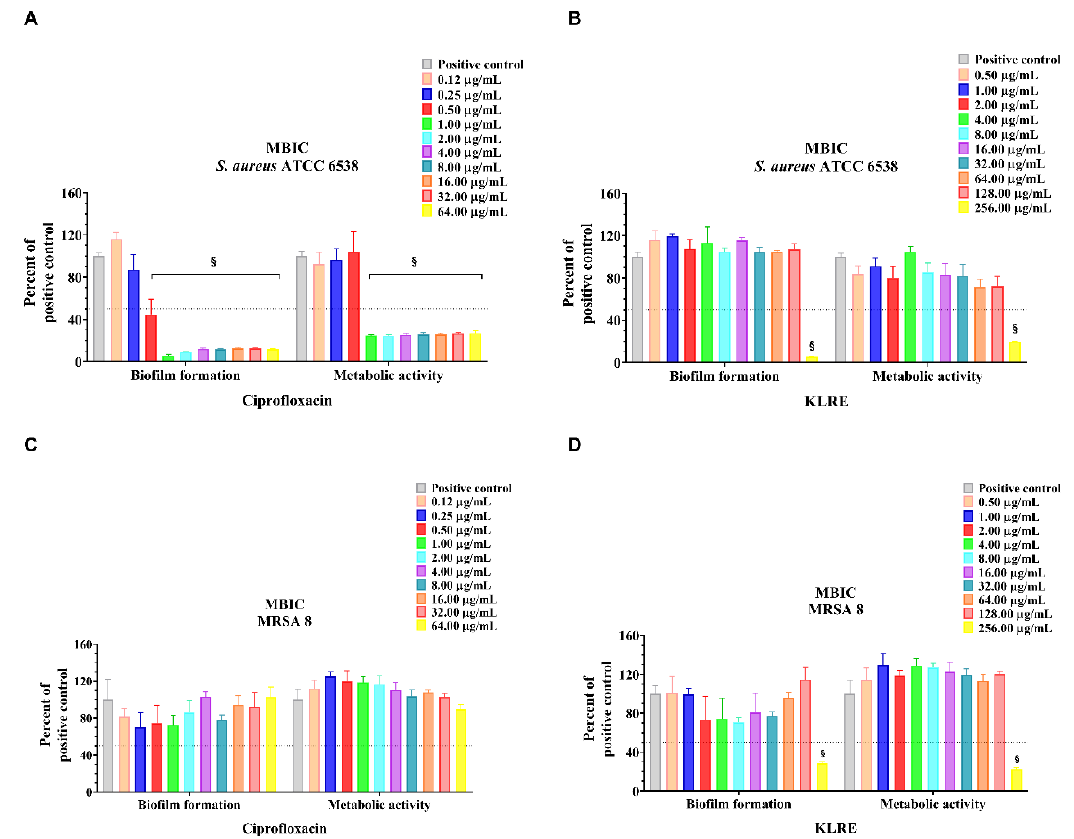
Figure 3. Minimal biofilm inhibitory concentration (MBIC) of ciprofloxacin and K. lappacea root extract (KLRE) on S. aureus ATCC 6538 and MRSA 8. S. aureus ATCC 6538 and MRSA 8 were exposed to different concentrations of ciprofloxacin ( A , C ), ranging from 0.12 to 64.00 µ g/mL or KLRE ( B , D ), ranging from 0.50 to 256.00 µ g/mL, for 24 h. In the x-axis are reported the biofilm formation and metabolic activity of untreated (positive control) and ciprofloxacin/KLRE treated bacterial strains. The values are expressed as a percentage of positive control. The bars represent the means ± SD of three independent experiments (SD = standard deviation). Statistically significant differences, determined by two-way analysis of variance ANOVA, are indicated § p ≤ 0.0001 versus positive